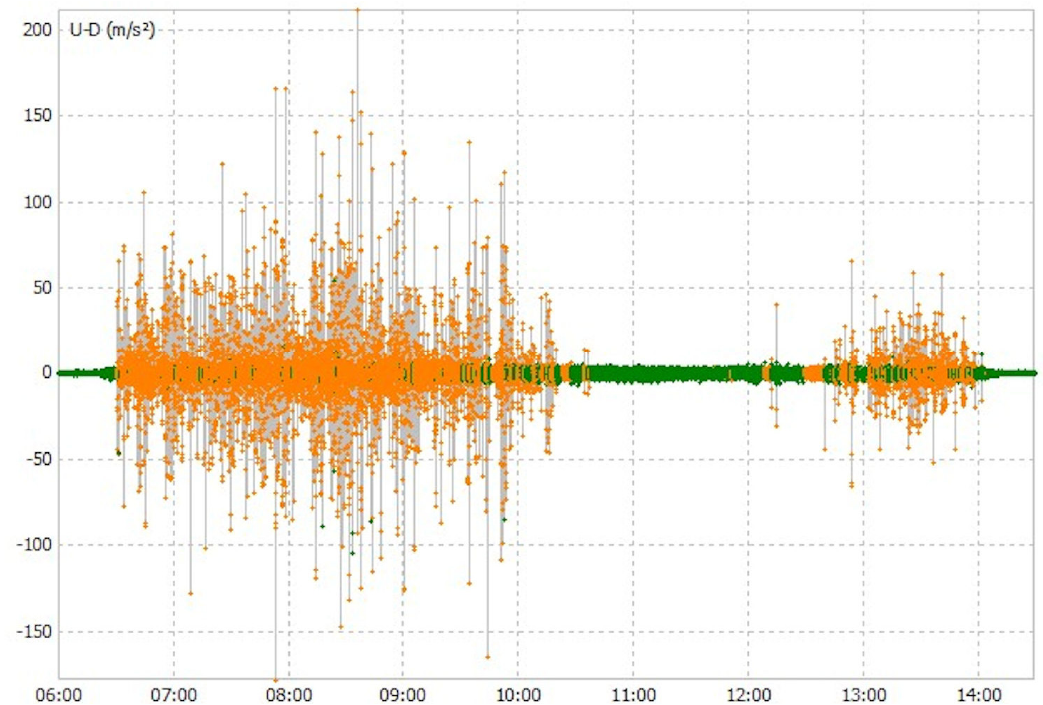
Figure 8. Buoy vertical accelerations during tidal cycle B; Up–Down (U-D), 29 August 06:00–14:30. Fixed solutions (Q1) are shown in green, and float solutions (Q2) are shown in orange.